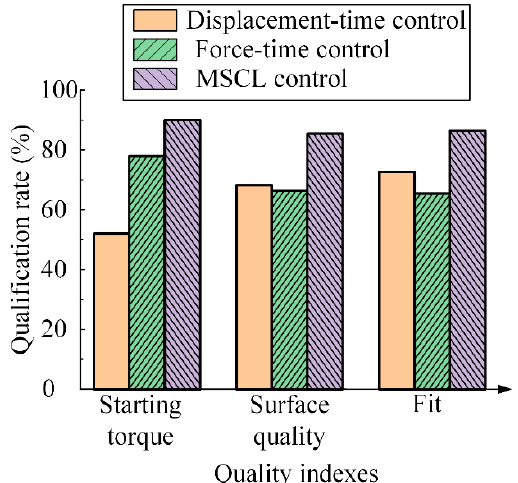
Figure 13. Qualification rates of different quality indexes under three loading control